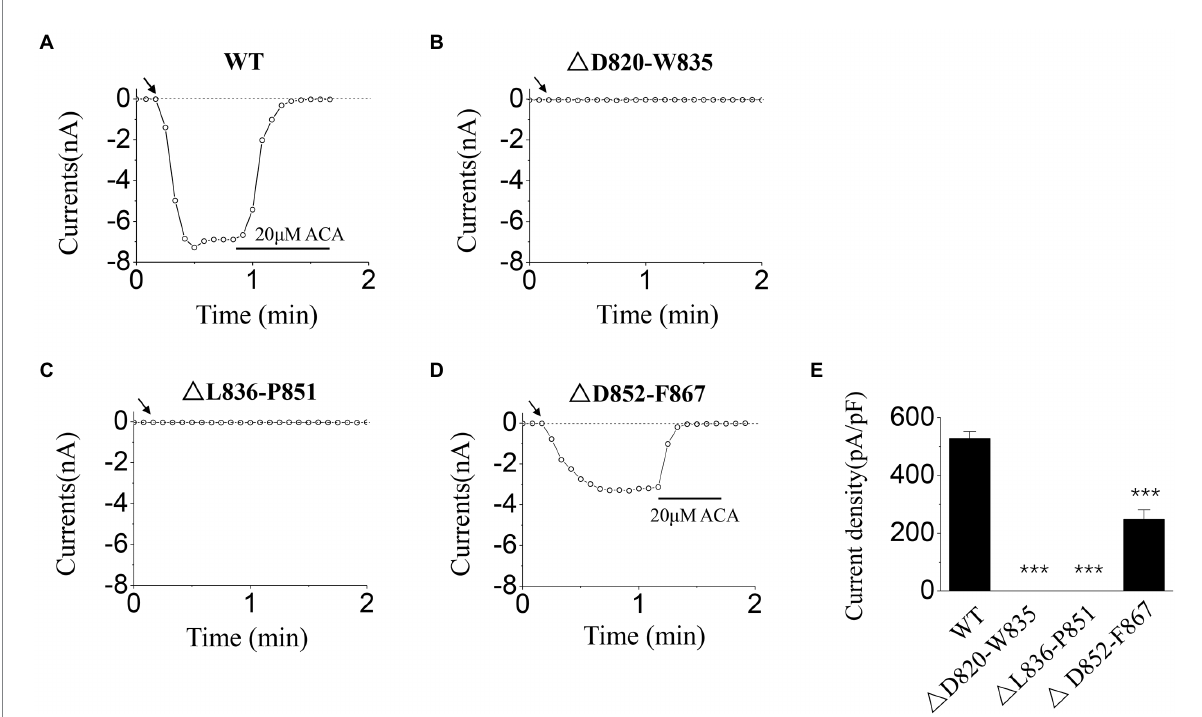
FIGURE 1 Functional assay of WT transient receptor potential melastatin 2 (TRPM2) and three deletion mutants. (A–D) Representative whole-cell recordings of TRPM2 channel currents induced by intracellular solution (ICS) of 500 μ M adenosine diphosphate-ribose (ADPR) from Human Embryonic Kidney 293 T (HEK293T) cells expressing (A) WT, (B) △ D820-W835, (C) △ L836-P851, and (D) △ D852-F867. The arrow in each panel indicates the time point at which whole cell configuration was established. (E) Summary of the current density induced in cells expressing WT and deletion mutants. In each case, six cells were tested. *** p < 0.001 compared with